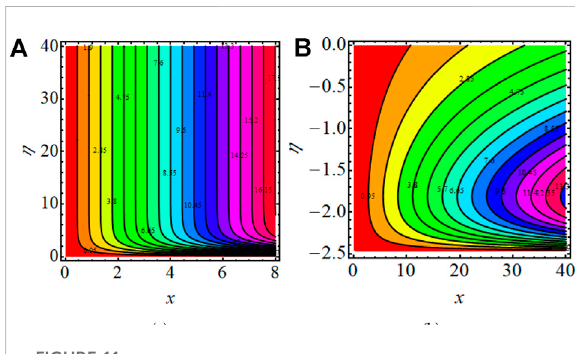
FIGURE 11 (A,B) We (cid:3) 0 . 5 and Rd (cid:3) 0 . 7 for stream line and isotherm line.